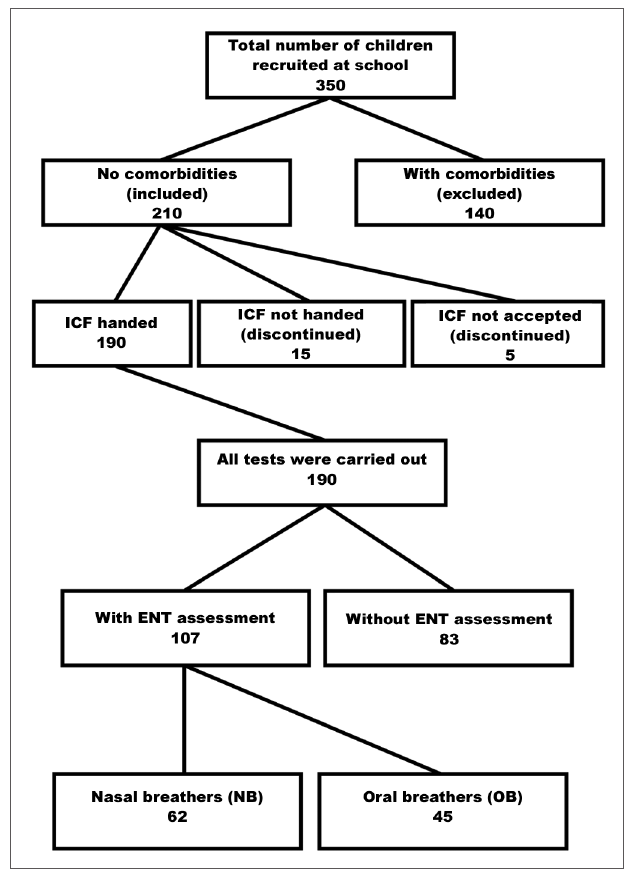
Figure 1. Sample screening. FICF (TCLE) - Free informed consent